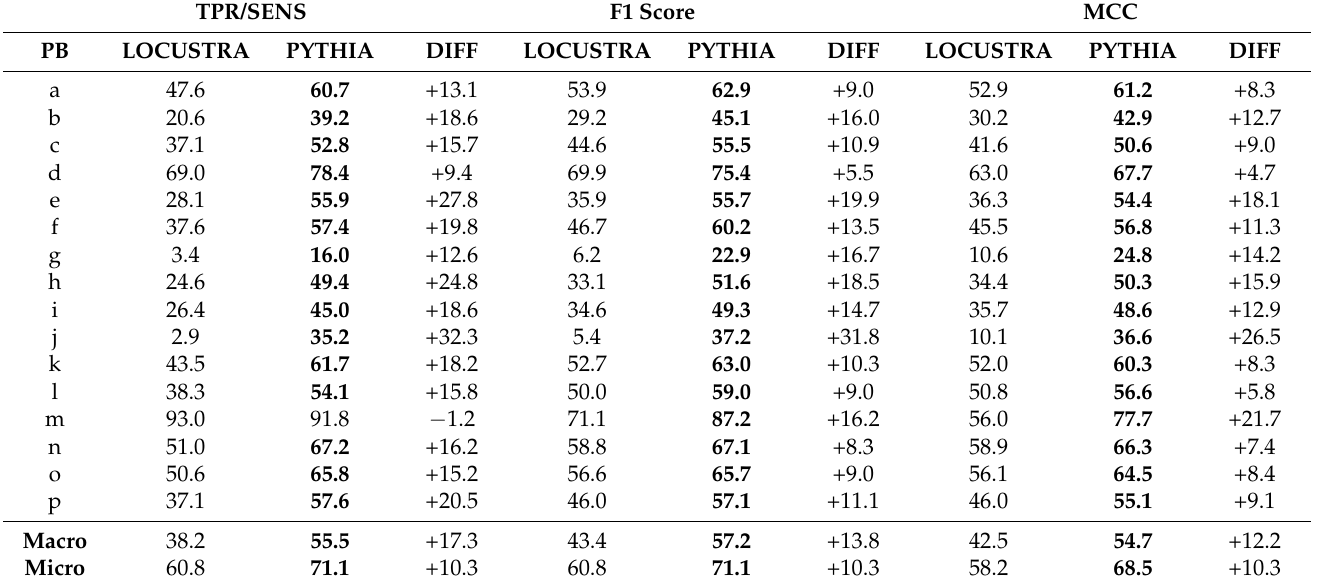
Table 1. Evaluation of performances of the global accuracy PYTHIA model compared to the reference method LOCUSTRA. Several statistical measures were used: True Positive Rate (TPR), F1-score and Matthew Correlation Coefficient (MCC). The DIFF columns represent in green the gain of performances in favor of PYTHIA and in red in favor of LOCUSTRA. The width of bars is scaled ac-cording to the highest value of the corresponding metric. We present two metrics for average: “Macro” average (averaging the unweighted mean per PB class) and “Micro” average (averaging the total true positives, false negatives and false positives). Micro average of TPR corresponds to Q 16